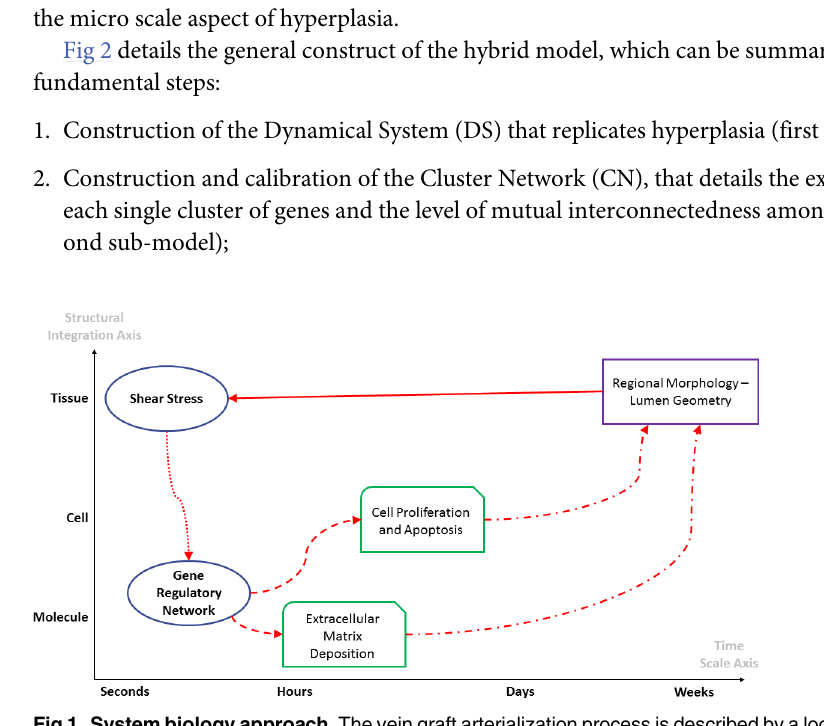
Fig 1. System biology approach. The vein graft arterialization process is describedby a loop of interdependent events, where the dynamicinterplaybetweenphysicalforces and gene network regulatesthe early graft